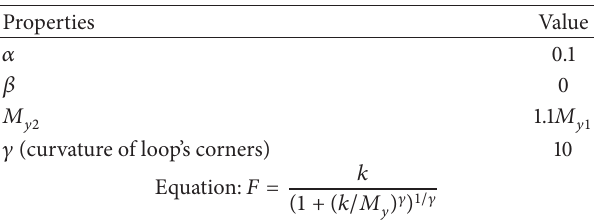
Table 2: Properties of the Menegotto-Pinto hysteretic loop and its governing